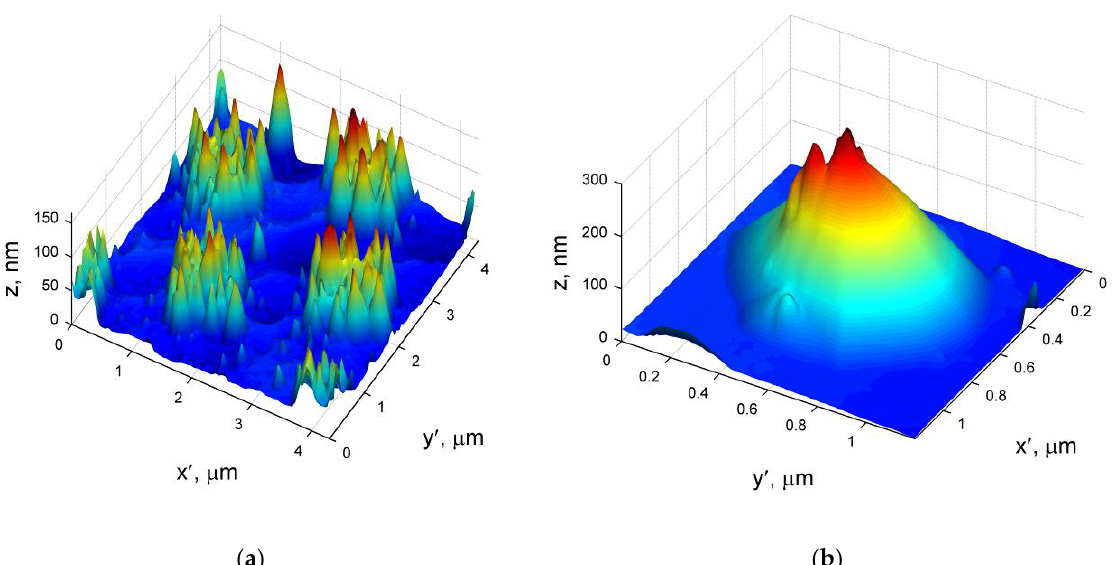
Figure 4. AFM images of domains created by Scheme A at U = 5 kV and D = 5000 µC/cm 2 using squares with sides equal of: ( a ) 1 µm, ( b ) 0.5 µm.